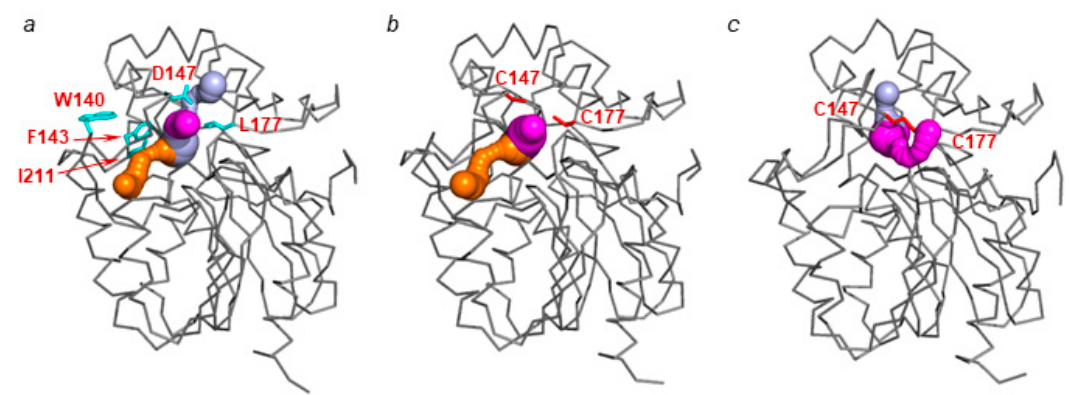
Figure 8. LinB access tunnels in ( a ) LinB WT (PDB ID: 2bfn, [18]), ( b ) LinB D147C+L177C crystal structure (PDB ID: 6s06, this study), and ( c ) LinB MD D147C+L177C model. Tunnels p1a, p1b, and p2 are shown as light blue, magenta, and orange, respectively. The residues W140, F143, L177, and I211 are shown as blue sticks, while the substitutions D147C and L177C are shown as red sticks. The protein chain is shown as a grey ribbon.